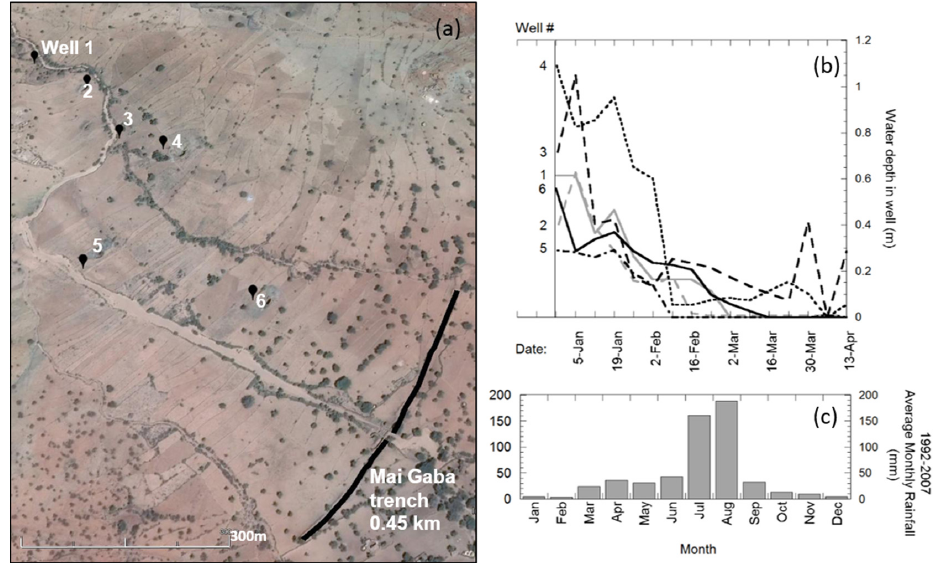
Figure 10. ( a ) Google Earth map of the observation wells and nearby Mai Gaba trench; ( b ) well depth observations for all six wells; and ( c ) monthly rainfall averages from 1992 to 2007 from nearby Hawzen meteorological station [38].